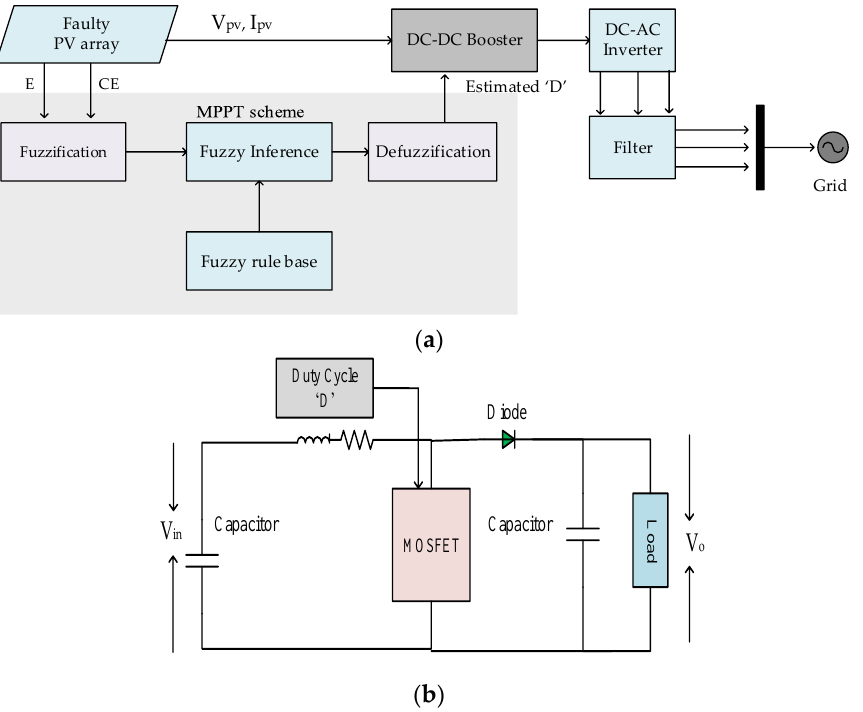
Figure 1. MPPT schemes: ( a ): Block diagram of PV system with FL-based MPPT. ( b ): Flow diagram of the proposed MPPT scheme.